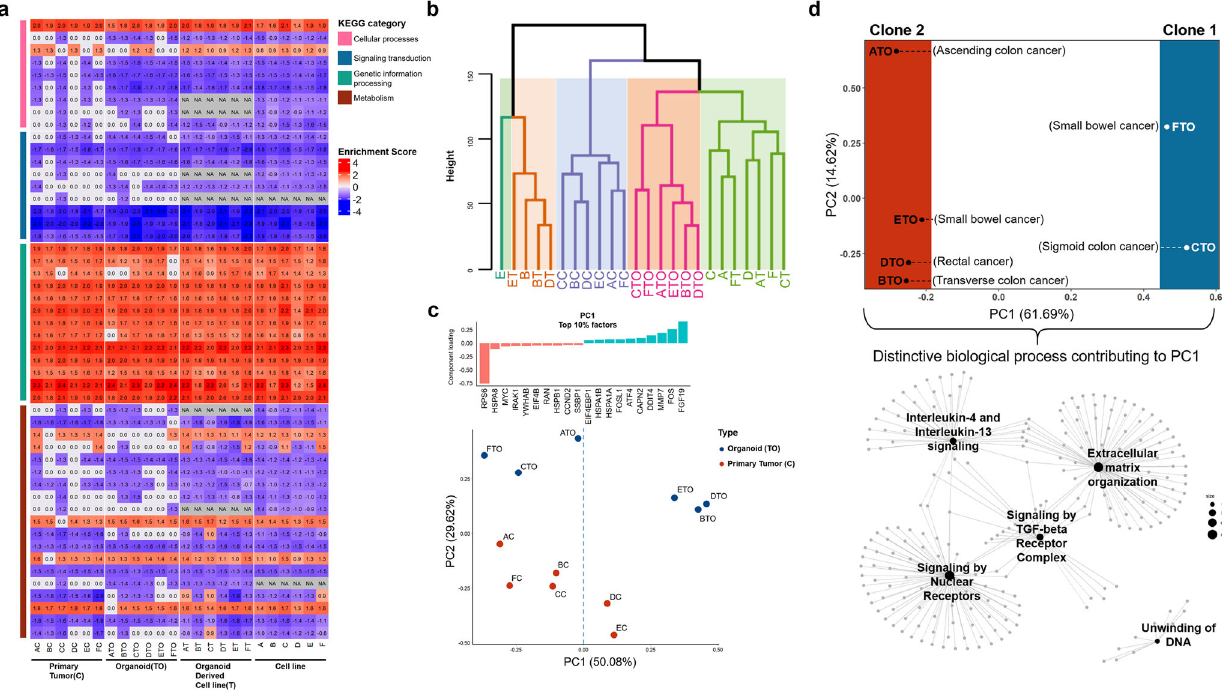
Fig. 3 Transcriptomic analysis demonstrated distinct mRNA expressional patterns according to different clonality. Related to Supplementary Fig. 4 and Supplementary Data 3 . a Gene Set Enrichment Assay (GSEA) analysis using normalized transcripts of all genes ( n = 35,993) of tumor tissues and corresponding derivatives compared to the normal tissue. The KEGG signaling pathway pathways are categorized and indicated with representative colors. A total of overlapped 50 pathways that were enriched in both tumors and PDOs were selected to identify the differentially expressed pathway between samples (red, upregulated; blue, downregulated). b Sample to sample distances of mRNA expressions of all genes ( n = 35,993) among tumor tissues ( n = 6) and corresponding derivatives ( n = 18) based on hierarchical clustering. Each cluster is marked with representative colors. The intact cluster of organoids was adjacent to the original tumors in Euclidean distance. c Principle component analysis (PCA) using values of normalized transcripts indicates tumor site D and E from the rest with principle component 1 (PC1) whereas principle component 2 (PC2) divided PDOs from tissue. Top 10% contributing variables in PC1 are indicated on the top of the PCA plot. d Gene Ontology of the top 5% genes contributing to the distinction of C- and F-TO from the rest (PC1) was performed with P -value < 0.05 as a cutoff. Among the selected 21 pathways in gene sets of the Reactome database, fi ve enriched biological processes ( p -value < 2.16E − 05) were indicated in